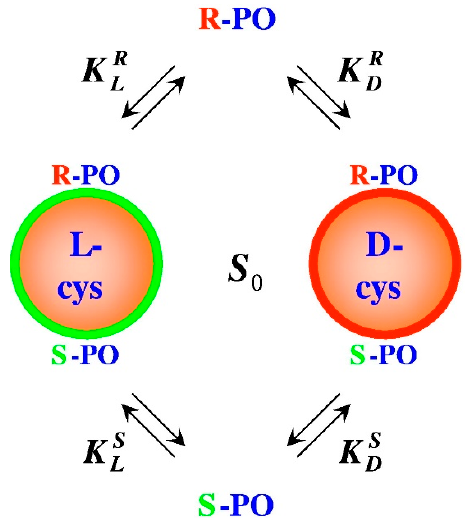
Figure 1. Recognition system developed by Shukla and colleagues. Reprinted with permission from [23], Copyright Elsevier, [23].